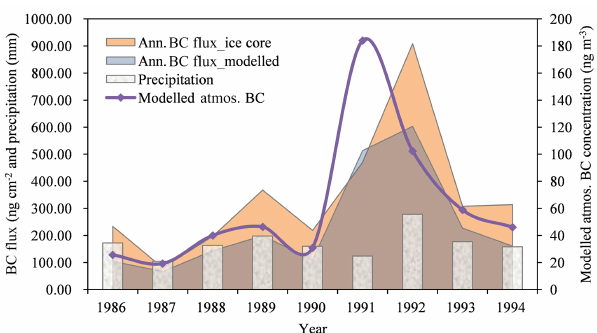
Figure 4. Comparison of measured annual BC deposition flux with the model calculation between ice core and simulation, as well as the modeled atmospheric BC concentration and precipitation used for BC deposition flux calculation. Figure 5. The image of the fires in Kuwait during 1991. It shows